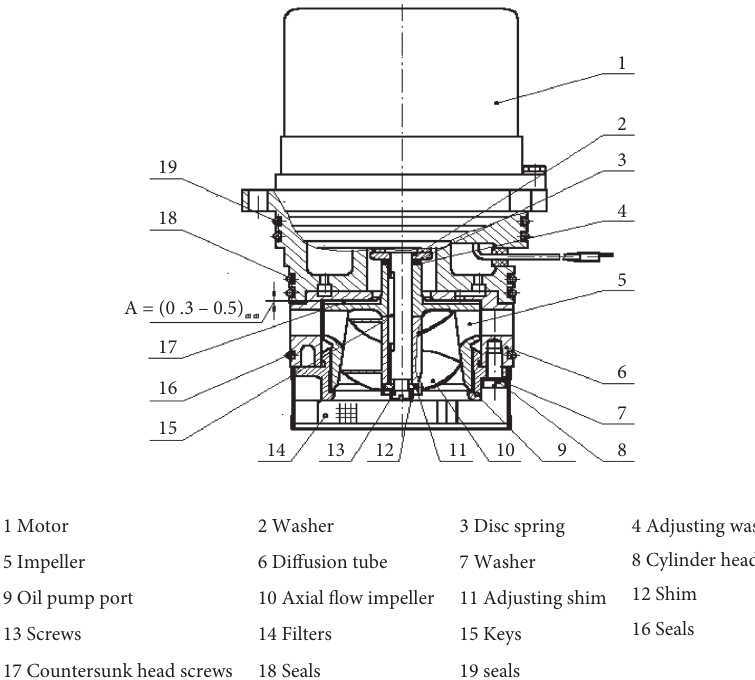
Figure 5: The structure of airborne fuel pump.